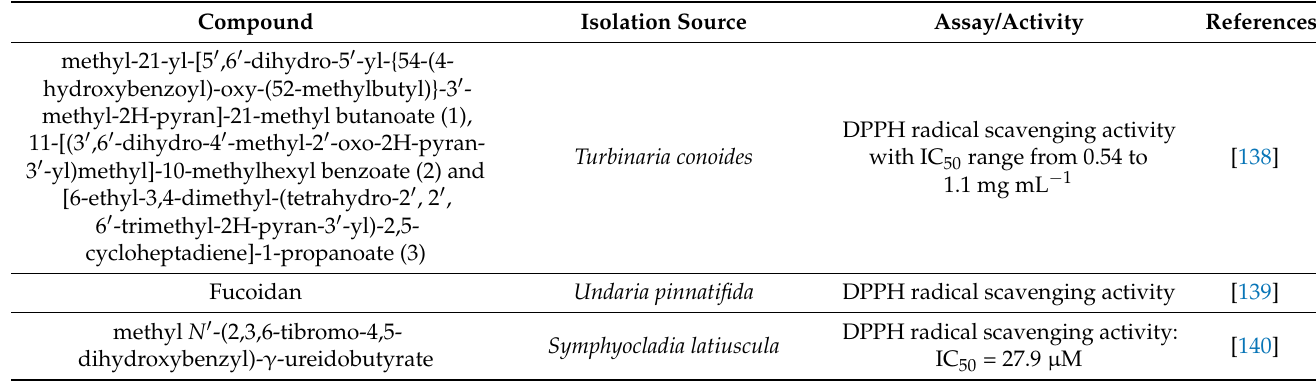
Table 3. Antioxidant activity of secondary metabolites synthesized from